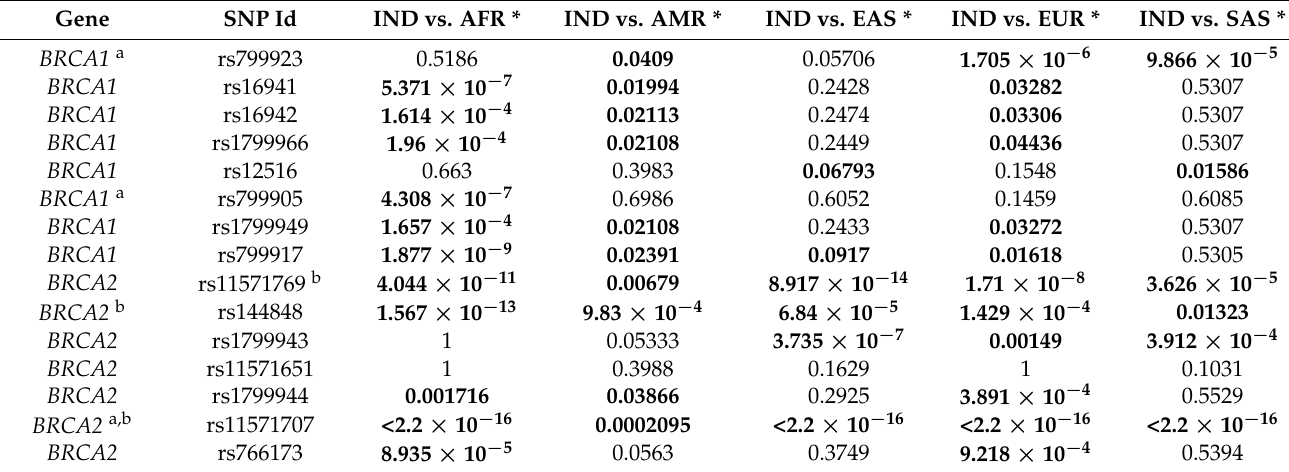
Table 2. Comparison between the allelic frequency of the study population Indian (IND) and continental populations (African (AFR), American (AMR), East Asian (EAS), European (EUR), and South Asian (SAS)) described in the 1000 Genomes